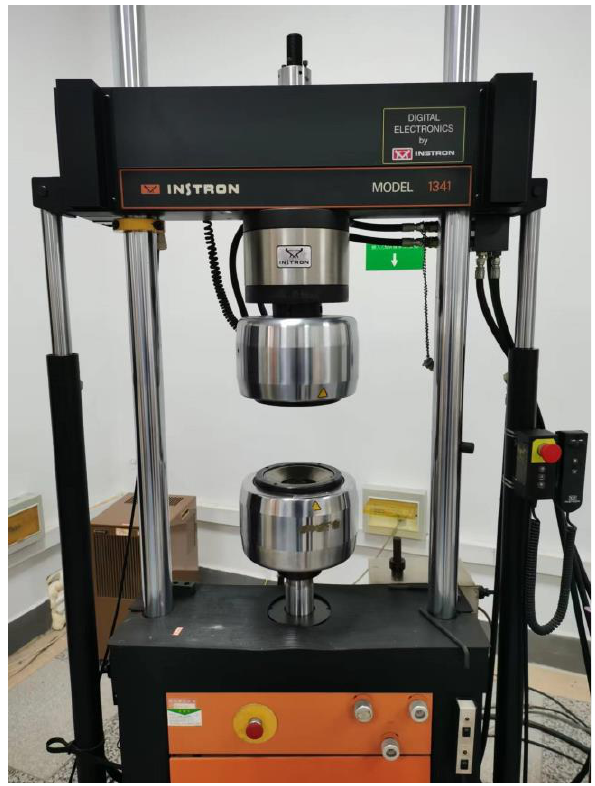
Figure 9. MTS hydraulic testing machine.